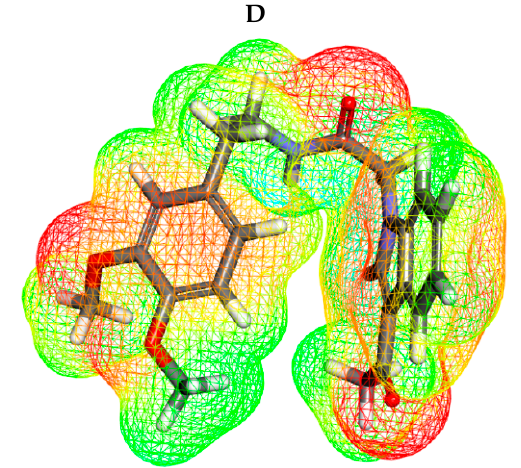
Figure 13. Molecular electrostatic potential map of ( A ) S88 , ( B ) 28 , and ( C ) 34 , and ( D ) 47.